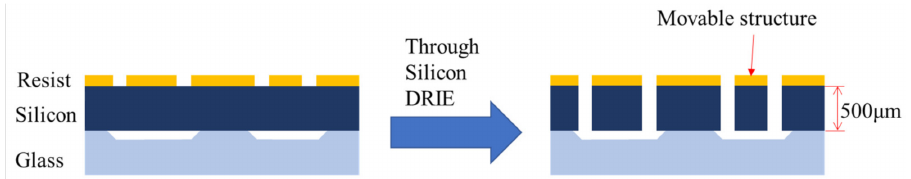
Figure 5. Schematic fabrication process. Through silicon DRIE is applied to the silicon layer of the bonded wafer. The minimum gap of the silicon layer is 25 µ m to attain an aspect ratio of